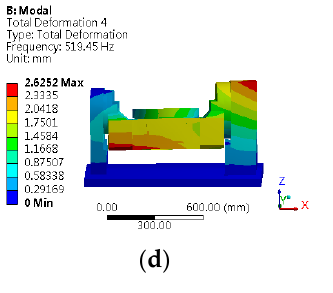
Figure 9. First six modes of turntable; ( a ) First mode; ( b ) Second mode; ( c ) Third mode; ( d ) Fourth mode; ( e ) Fifth mode; ( f ) Sixth mode. Table 3. First six-order natural frequencies of the turntable.